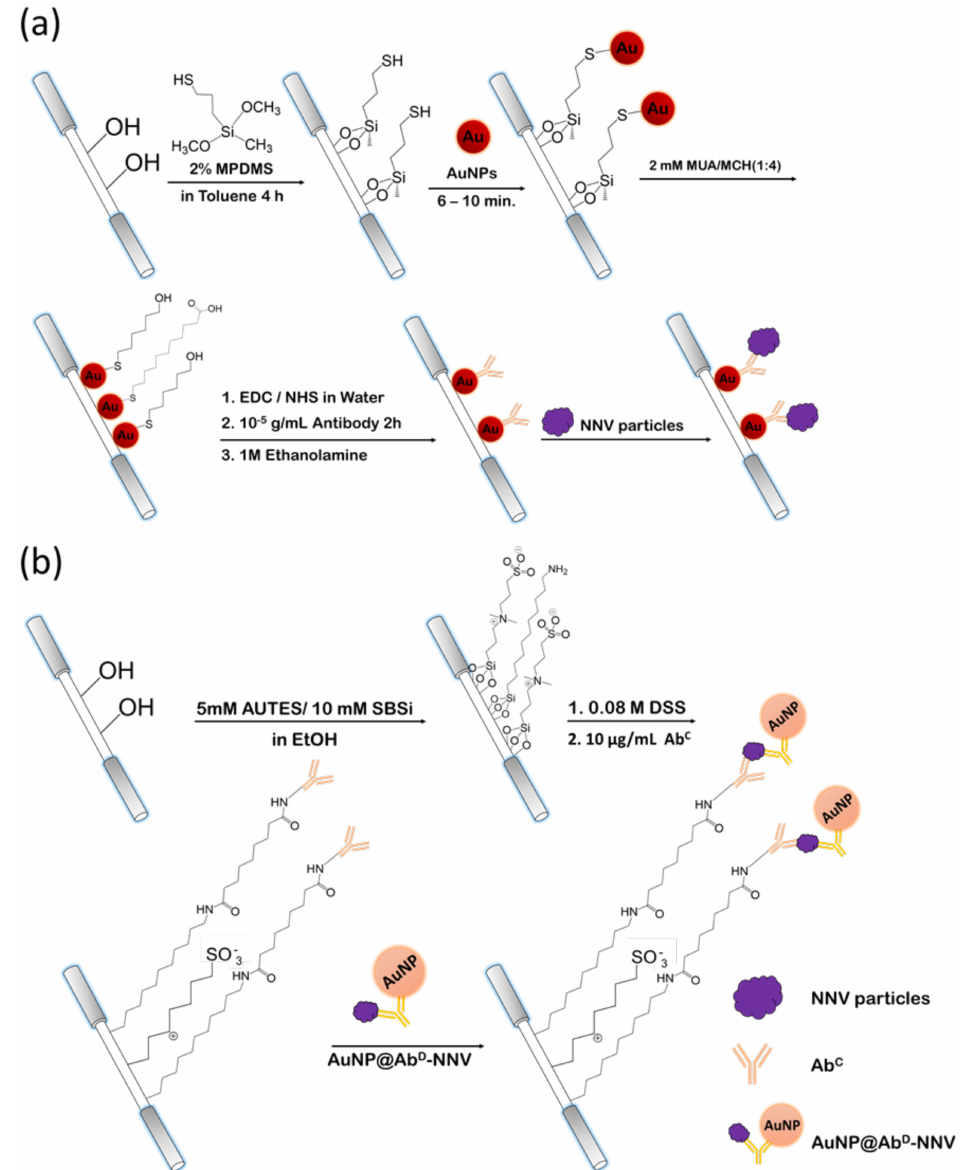
Scheme 1. Schematic of the steps involved in the fabrication of sensing fibers and the corresponding biosensing strategies for ( a ) direct method and ( b ) FONLISA